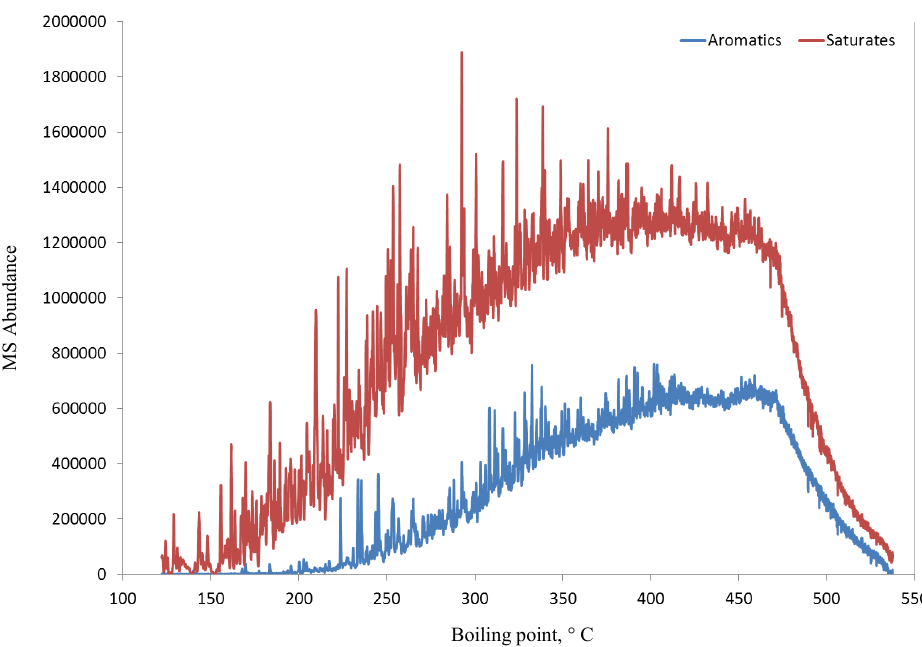
Fig. 3. Distribution curve of saturated and aromatic hydrocarbons in the oil sample under study versus their boiling